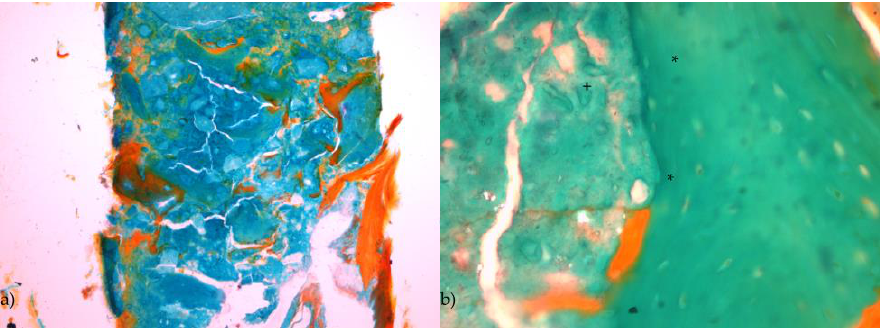
Figure 6. Histologic specimen of region 26 (Masson-Goldner staining). ( a ) Trephine core showing the close contact between the vital bone and the scaffold with a denser structure in the cranial area of the core (Magnification: 10-fold). ( b ) Detail showing the close contact between bone (*) and scaffold material (+) without a gap (Magnification: 40-fold).